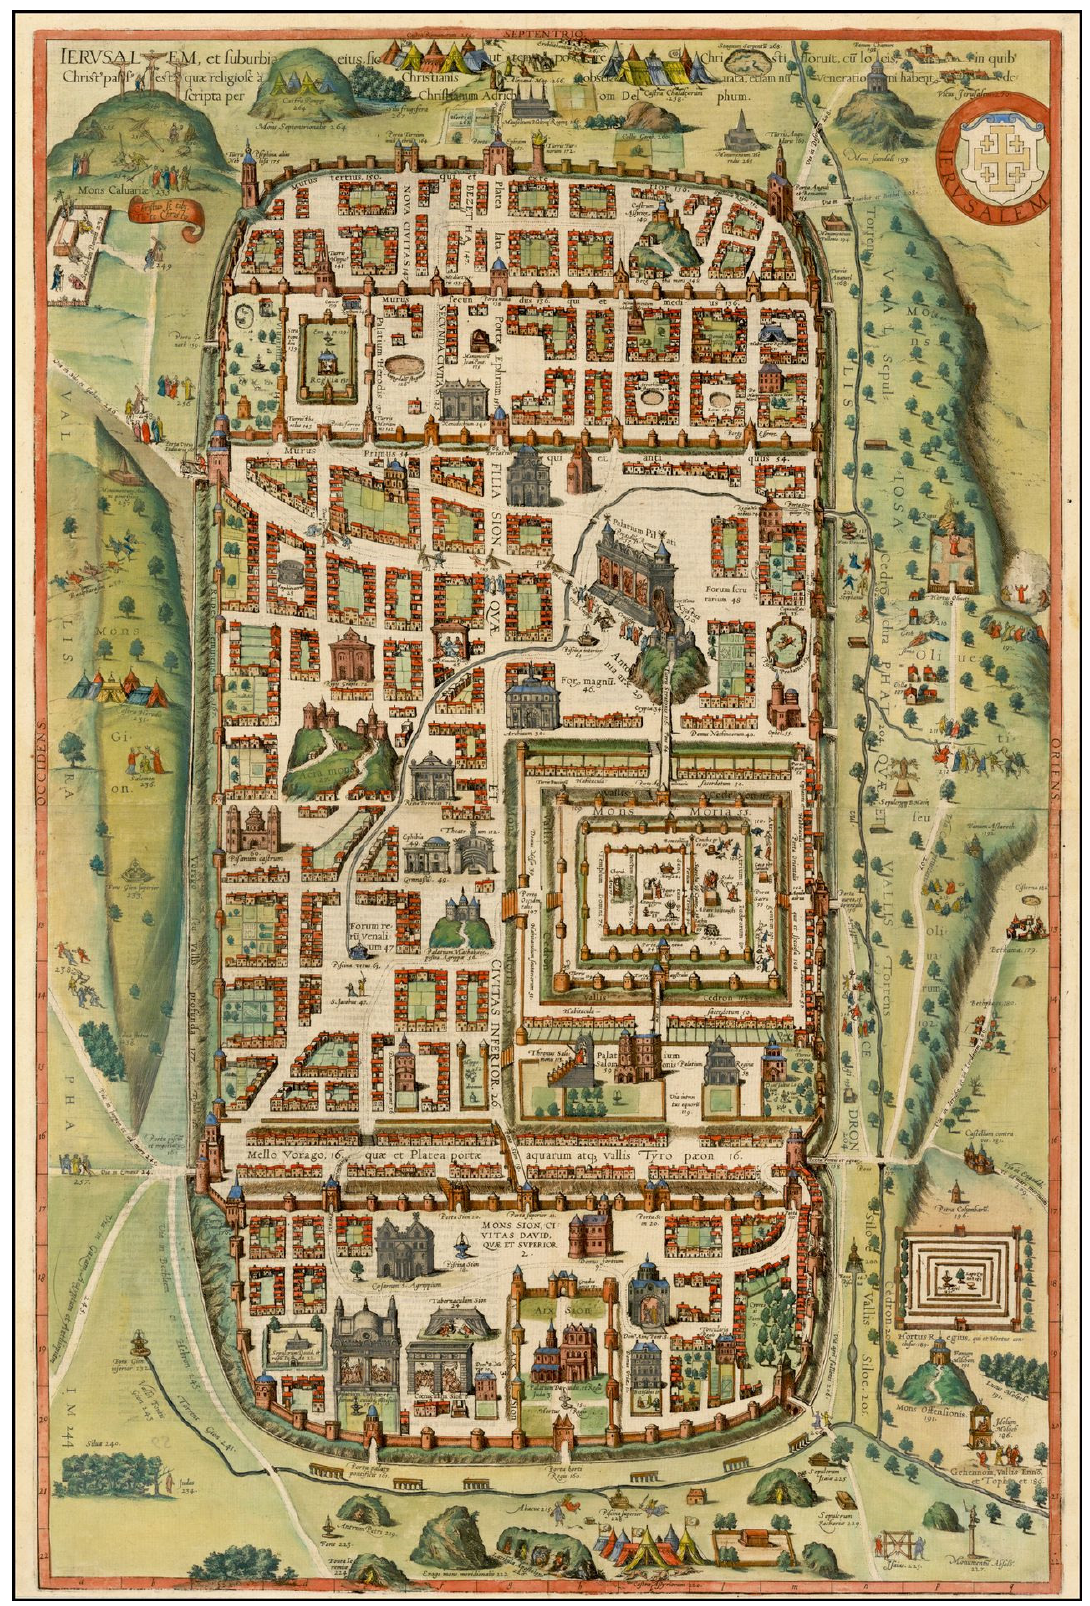
Figure 13. Christian van Adrichom, Map of Jerusalem with Via crucis , from Georg Braun and Frans Hogenberg, Civitates orbis terrarum (Cologne, 1590).